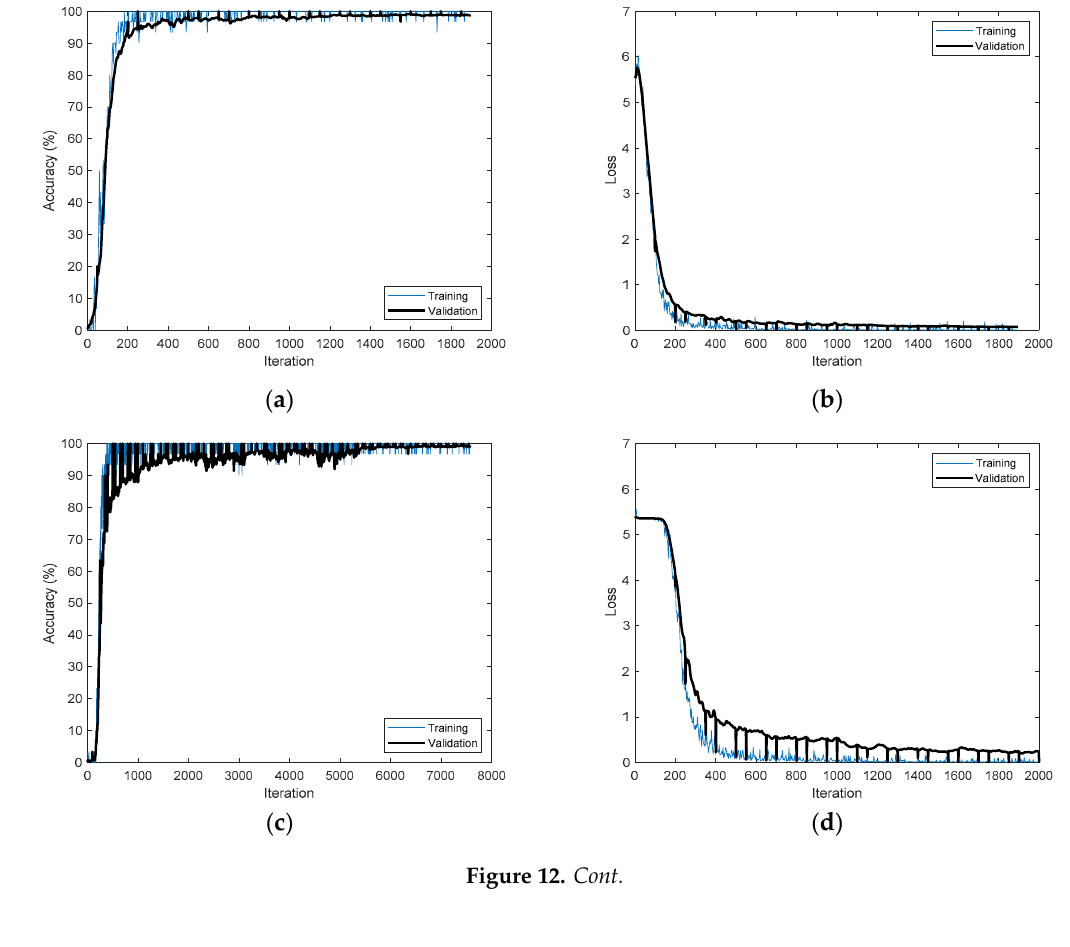
Figure 12. Cont . Figure 12.